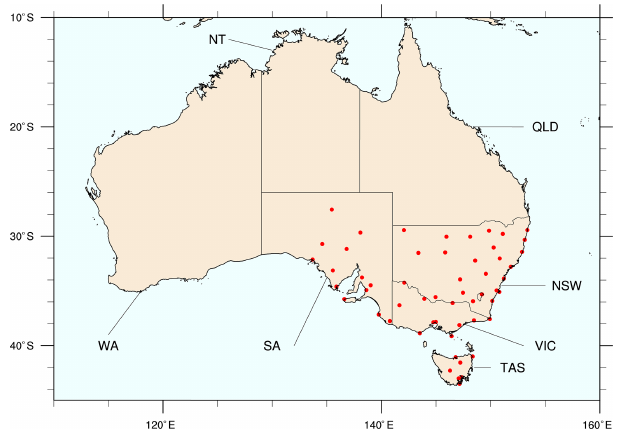
Figure 1. Map of Australia showing the states of south-eastern Australia (SEA): South Australia (SA), Tasmania (TAS), Victo- ria (VIC), and New South Wales (NSW). Other states shown are Queensland (QLD), Northern Territory (NT), and Western Australia (WA). Red dots indicate the Australian Bureau of Meteorology’s (BoM) monitoring stations used in this study (see Sect.